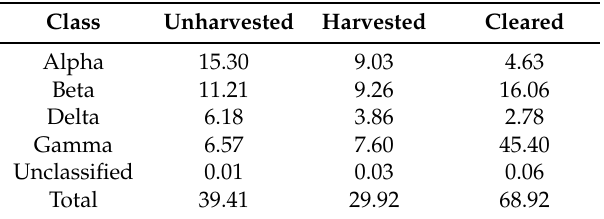
Table 3. The relative sequence abundance (%) of Proteobacteria for different microcosms by